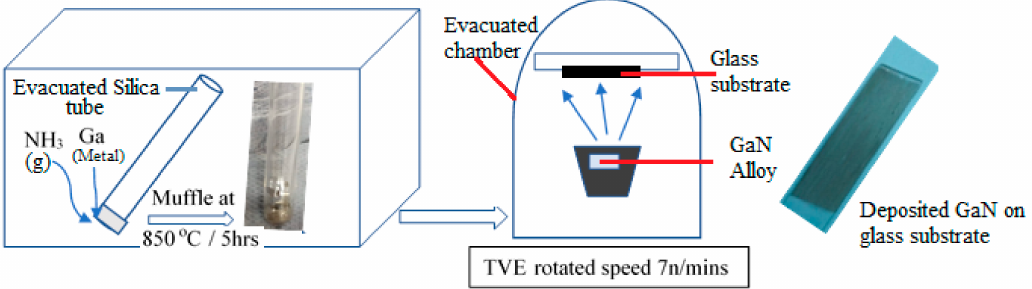
Figure 1. Scheme diagram of the experimental